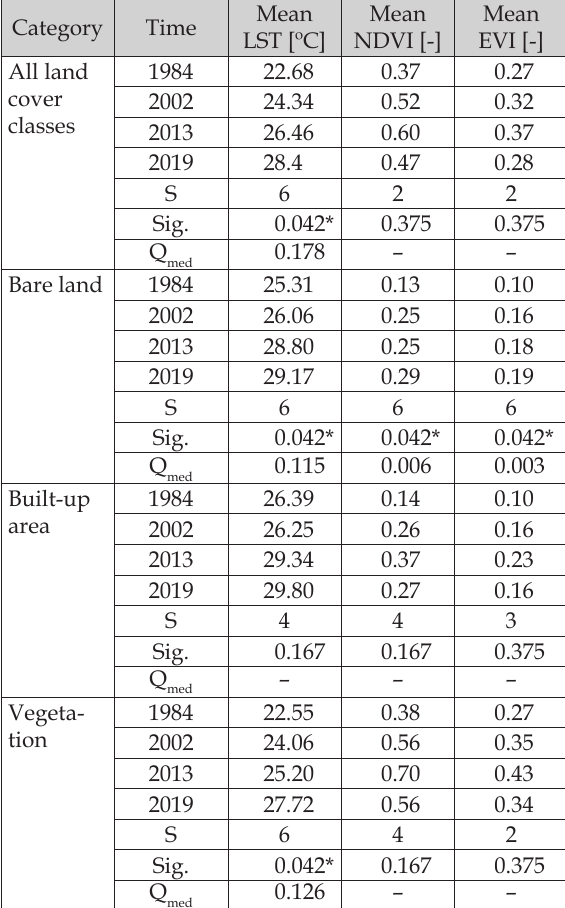
Table 12. Trend Analysis using the Mann-Kendall